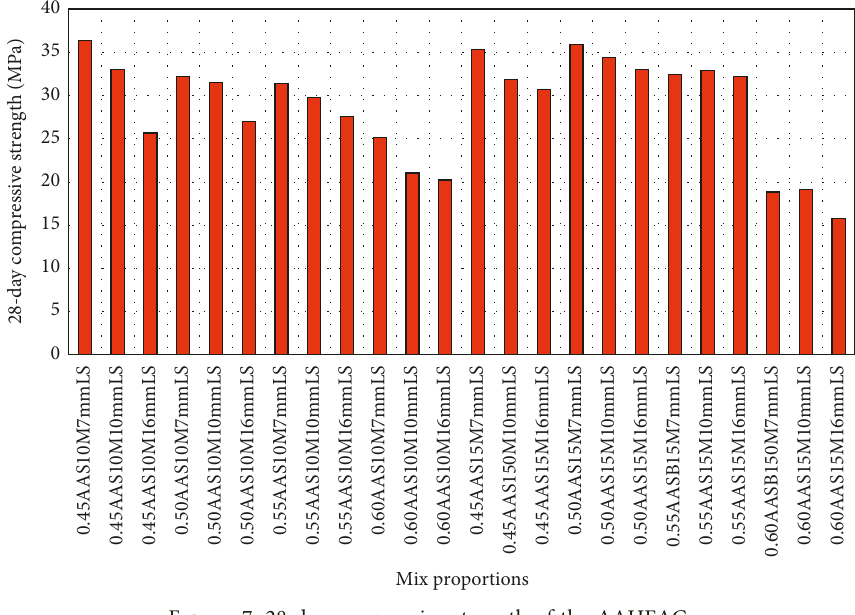
Figure 7: 28-day compressive strength of the AAHFAC.